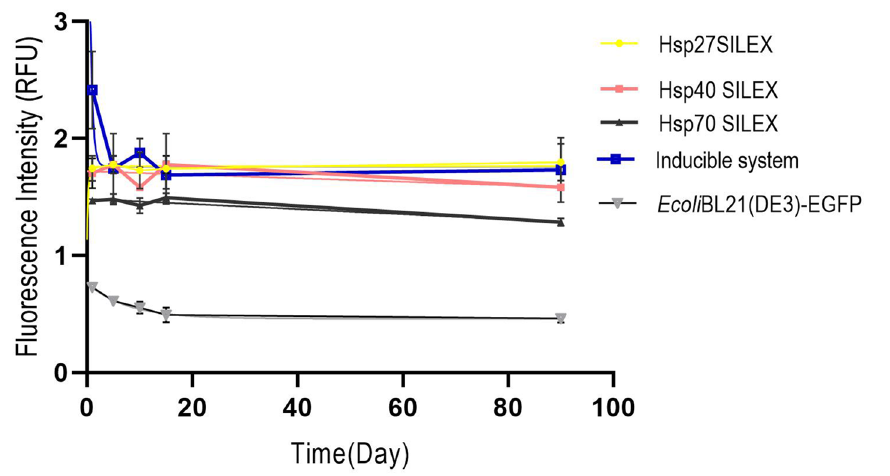
Figure 3. The expression level monitoring of transformed bacteria after four freeze-thawing cycles at − 70 °C within 90 days. Escherichia coli Bl21 (DE3) containing plasmid pET28a-EGFP was also evaluated without adding the inducing agent to observe the basal expression of the target protein. Data are represented as Mean ± SD from three independent